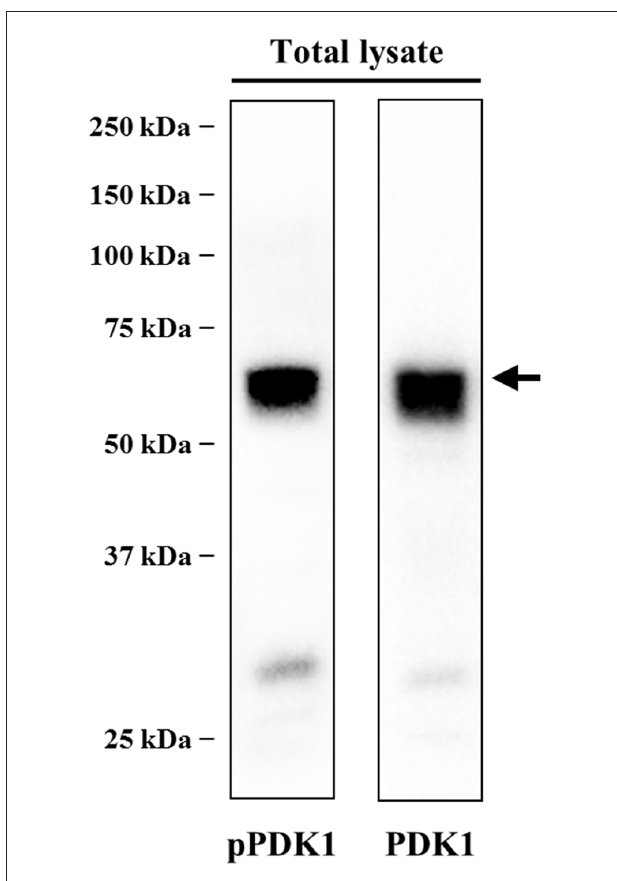
FIGURE 1 | PDK1 is expressed in skeletal muscle in basal conditions. Determination of the specificity of anti-phosphorylated PDK1 (pPDK1) S241 antibody (CS-3061) and anti-PDK1 antibody (sc-17765) by immunoblotting. Thirty microgram of protein from total lysate were size fractionated by SDS-PAGE on 8% acrylamide minigels and transferred to polyvinylidene difluoride (PVDF) membranes. The antibodies used only recognized the corresponding protein, reacting with a band consistent with its predicted molecular weight. Western blot analysis revealed significant amounts of PDK1 and pPDK1 in the skeletal muscle in basal conditions. Abbreviations: PDK1, phosphoinositide-dependent kinase 1; pPDK1, phosphorylated phosphoinositide-dependent kinase